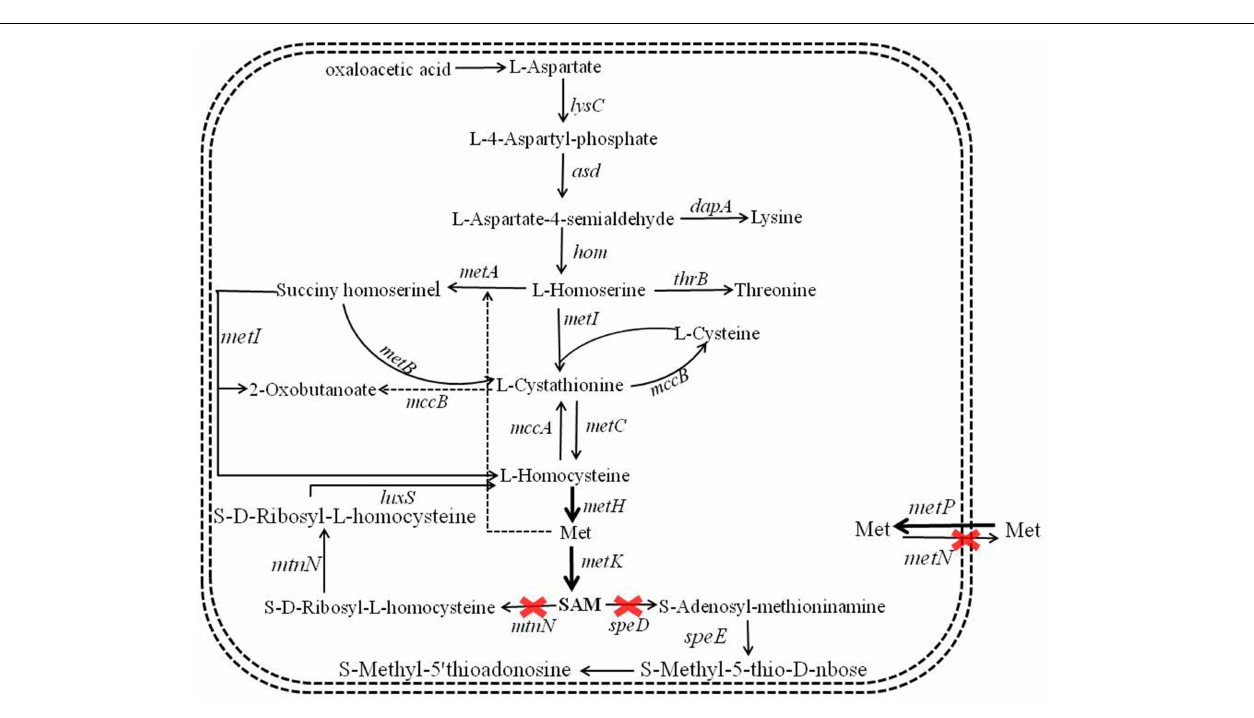
bacitracin produced by per cell was 1.98 ∗ 10 − 8